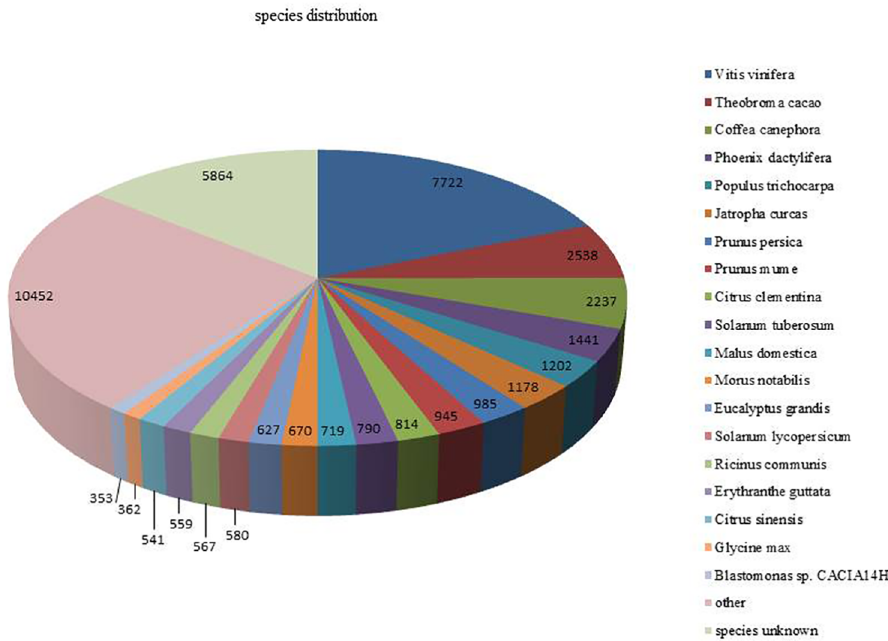
Fig 1. Results of species distribution of sequence homology search against NCBI NR database for C . officinalis unigenes.